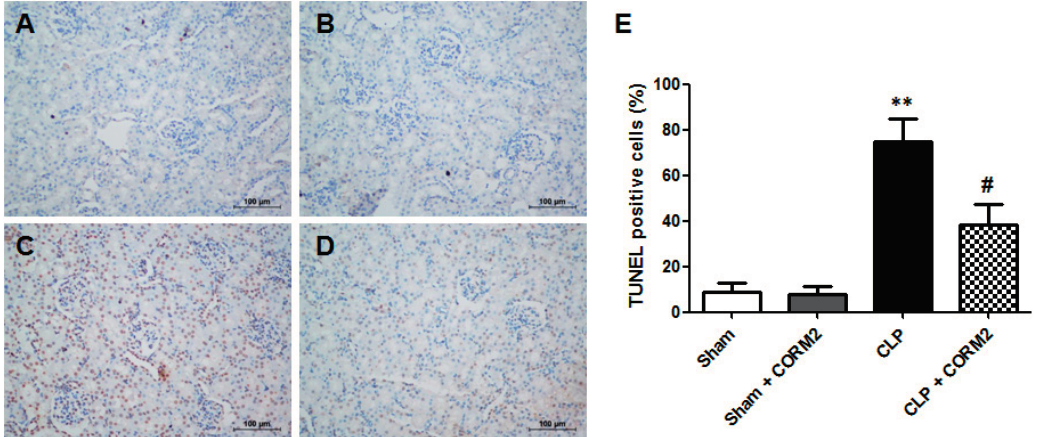
Figure 3. Carbon monoxide significantly decreased apoptosis in renal tissues of septic